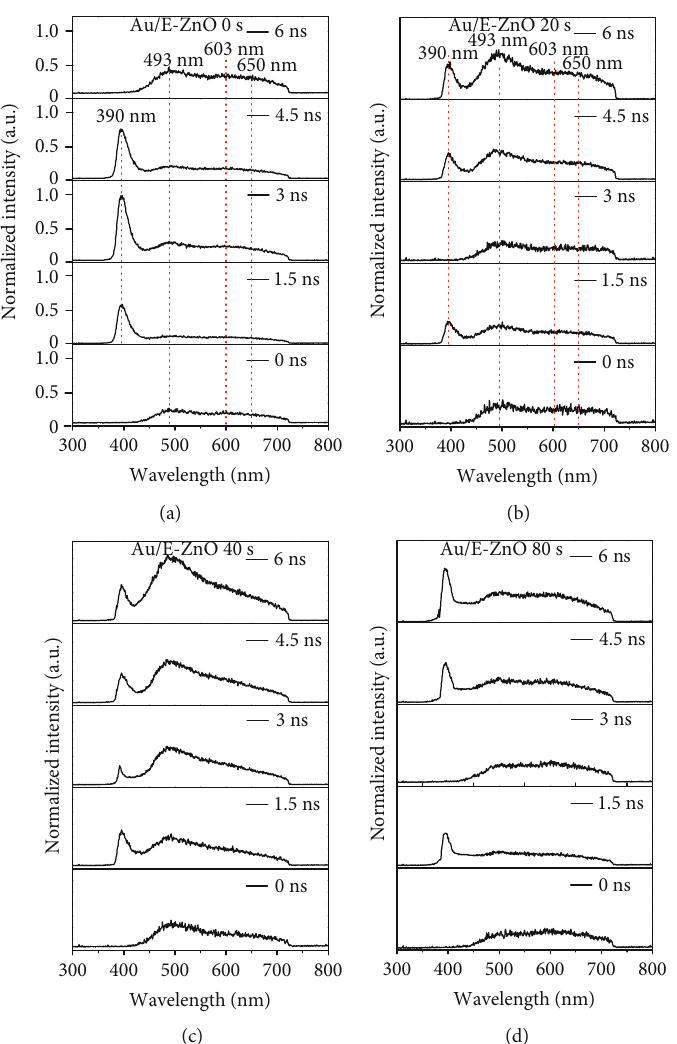
Figure 10: (a) – (d) Normalized nanosecond time-resolved transient photoluminescence (NTRT-PL) spectra of the pristine E-ZnO and Au/E- ZnO Schottky heterojunction nanocomposites for di ff erent deposition times (20 s, 40s, and 80 s), respectively.